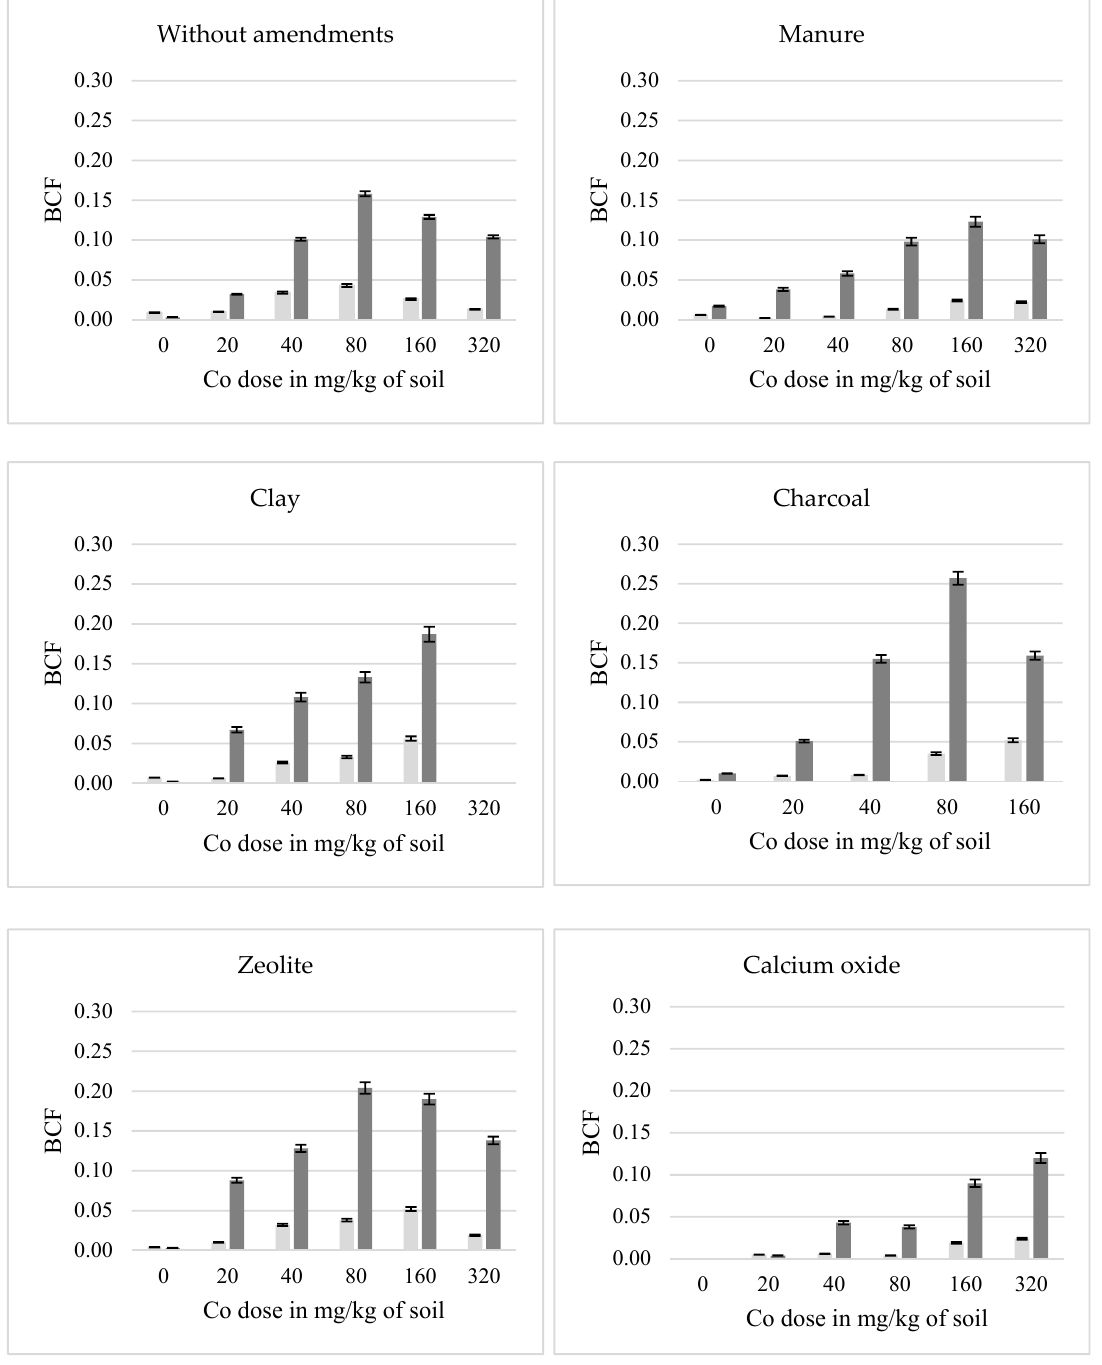
■ ■ above-ground parts roots